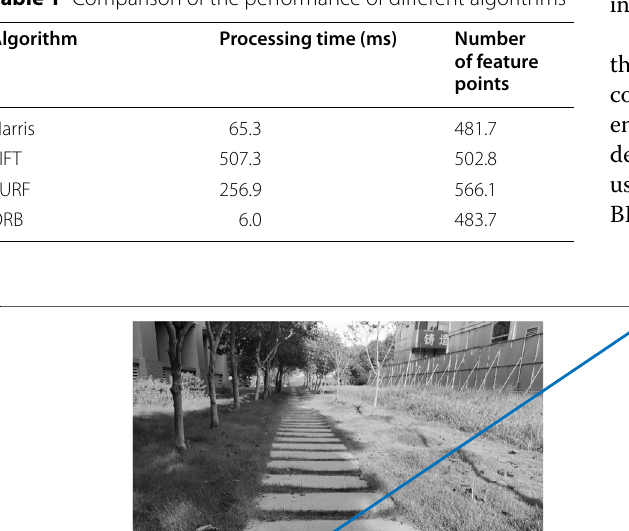
algorithm, optical flow algorithm and feature match- ing algorithm. Optical flow method and gray projection